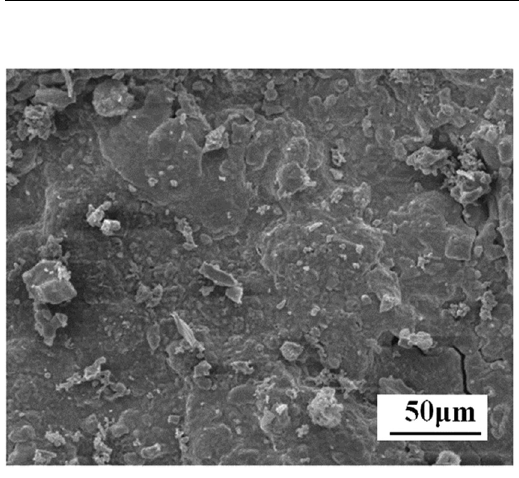
Figure 2: Microstructure of the oxide scale.